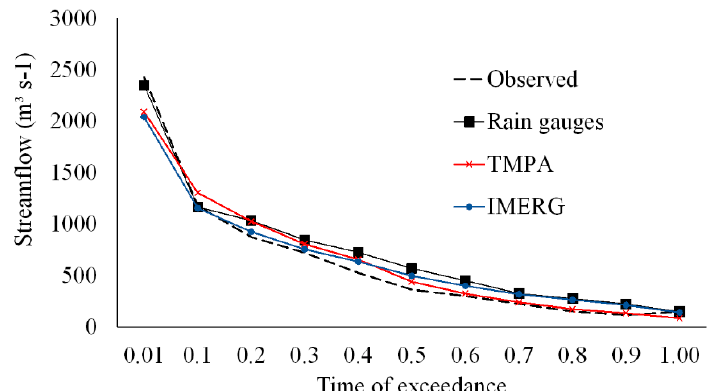
Figure 6. Observed 95% prediction uncertainty (95PPU) and simulated monthly streamflow driven by ( a ) TMPA, ( b ) IMERG, and ( c ) rain gauges. The yellow circle represents an anomaly in the simulated streamflow driven by SPPs.